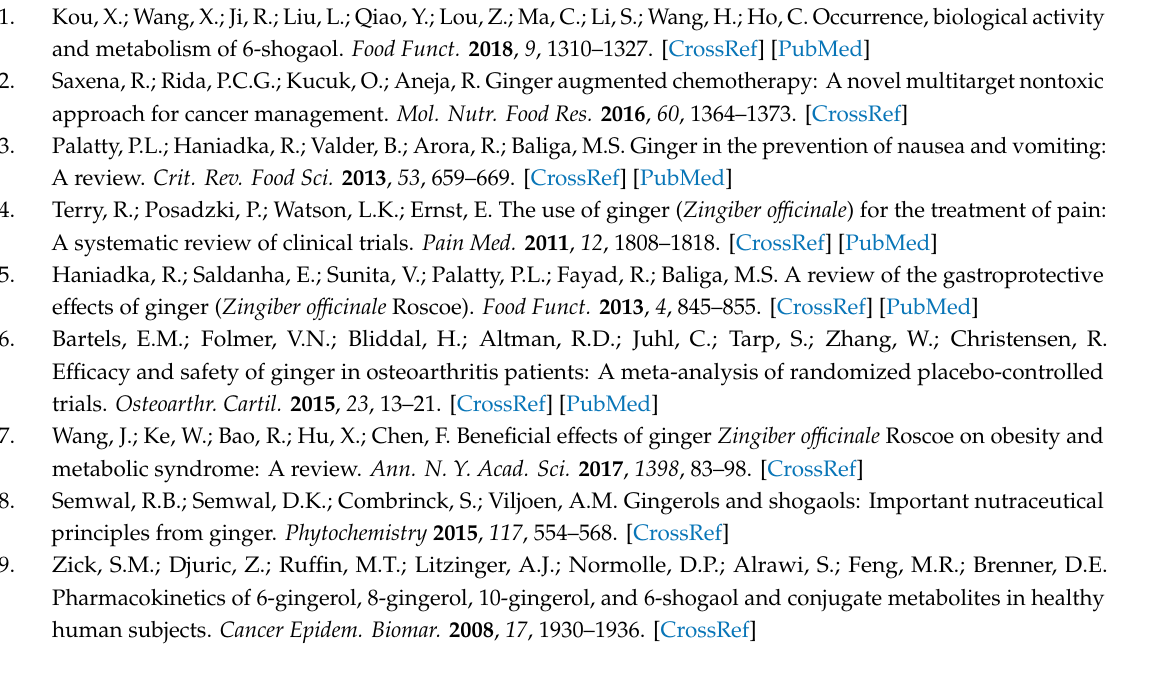
Table S1: Retention time, quantitation ion, and calibration curves for major polyphenolic compounds of